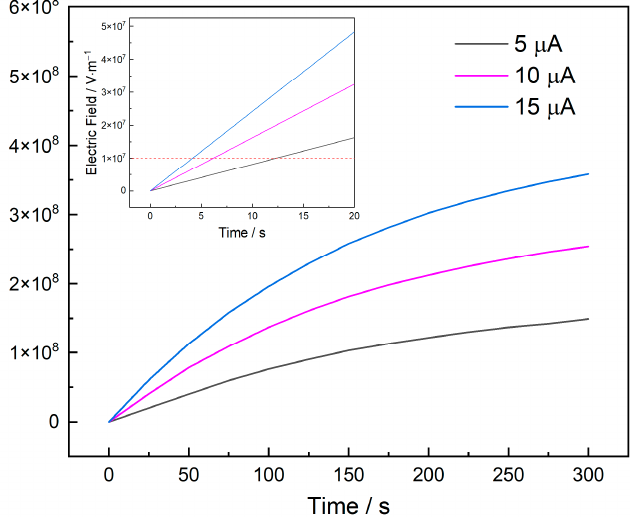
Figure 13. Simulation results of the maximum electric field under the radiation of three electron beam currents at 0.3 MeV.